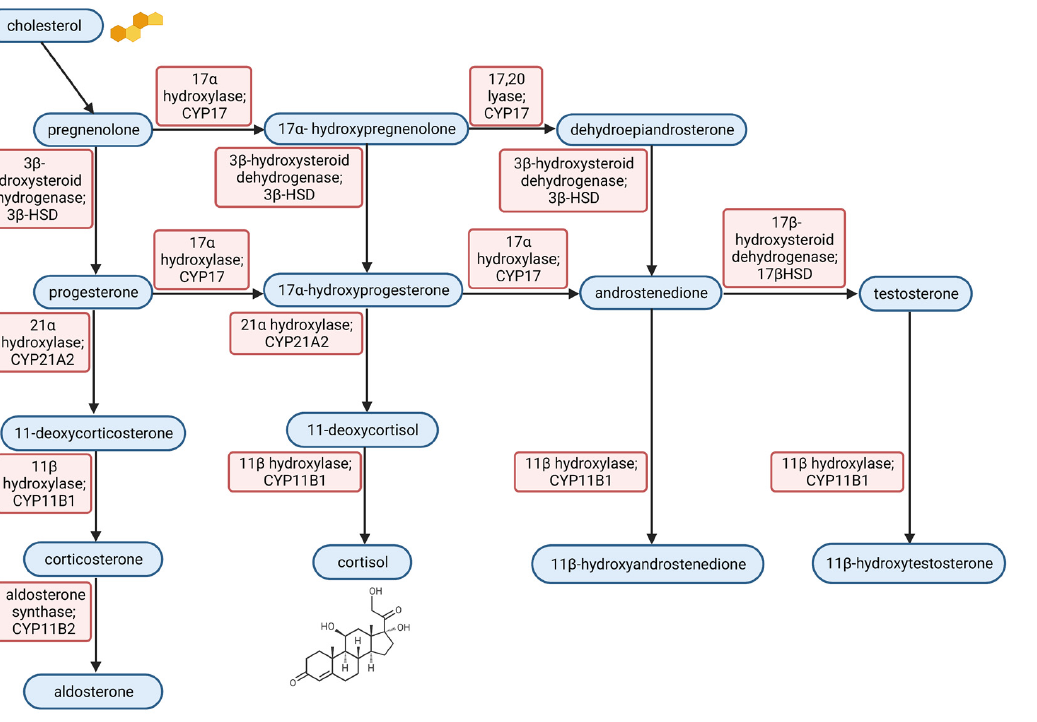
Figure 2. Steroid synthesis pathway. Steroid hormones are mostly synthesised in the adrenal cor- tex, with some sex steroid steps occurring in the gonads (not demonstrated here) from cholesterol. The small changes and multiple steps result in a wide range of structurally similar end hormones and precursors, which can cross-react with both assays and in vivo receptors. Created with Biorender.com [13–15].